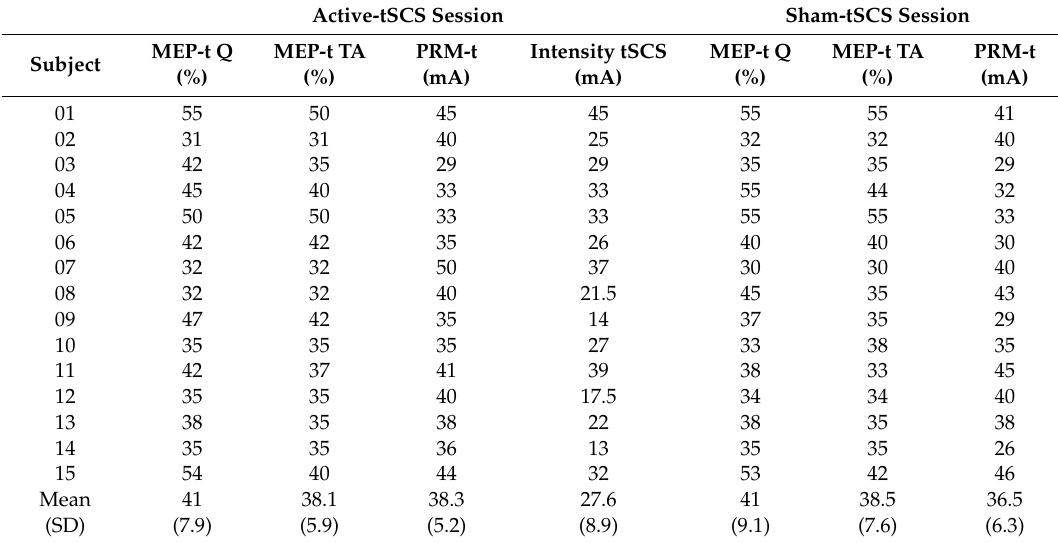
Figure 1. Consolidated Standards of Reporting Trials (CONSORT) flow diagram. Table 1. Neurophysiological assessment at baseline time for each